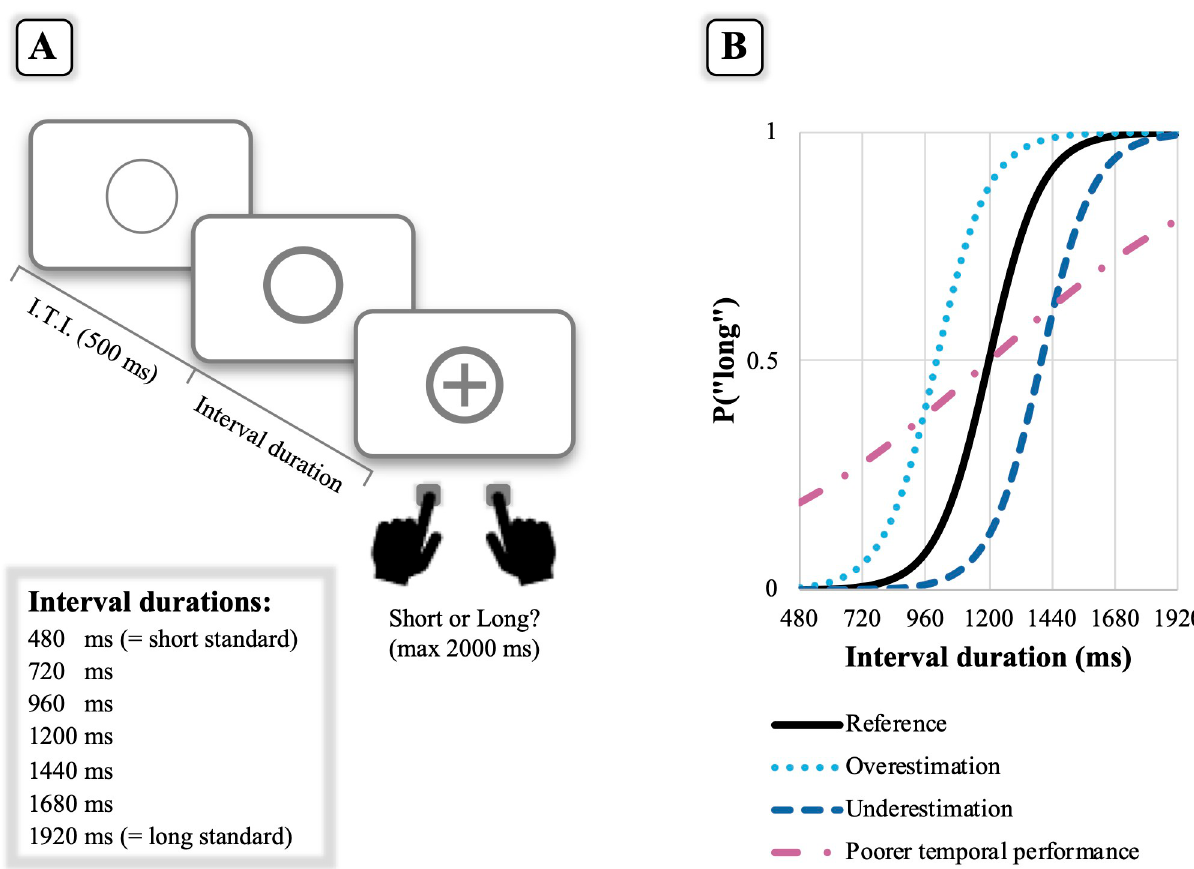
Fig 1. (A) Schematic view of the explicit (time bisection) task. In a first training phase, participants memorized a “short standard” (480 ms) and a “long standard” duration (1920 ms). In a subsequent testing phase, they indicated whether the interval duration elapsing from the onset of the thicker circle to the onset of the cross was closer to the previously memorized “short standard” or “long standard”. Responses were given by pressing two response keys on the computer keyboard. I.T.I. stands for Inter-Trial-Interval. (B) Patterns of behavioural performance in the time bisection task. A common way of looking at performance on the time bisection task is to construct a psychometric curve by plotting the proportion of trials in which participants respond “long” as function of interval duration. The black psychometric curve depicts an ideal performance in which participants never respond “long” to the short standard duration, whereas they always respond “long” to the long standard. At the intermediate duration (1200 ms), they are equally likely to respond short or long. Relative to the reference, a shift of the psychometric curve towards the left (light blue line) or the right (blue line) means over- or under-estimation, respectively. Conversely, a flatter psychometric curve (pink line) is indicative of a poorer temporal performance (i.e., participants tend to respond “short” to long durations and “long” to short durations). Although it is difficult to completely isolate clock (i.e., “temporal processing”) from memory/decision stages (i.e., “cognitive control functions”), it makes sense to hypothesize that age-related changes in clock speed should be mainly expressed by a rightward shift of the psychometric curve (i.e., a slower clock in older adults). By contrast, a flatter psychometric curve in older adults could be likely attributed to a deficit in the additional cognitive control functions (e.g., working memory) thought to be required to correctly perform on the time bisection